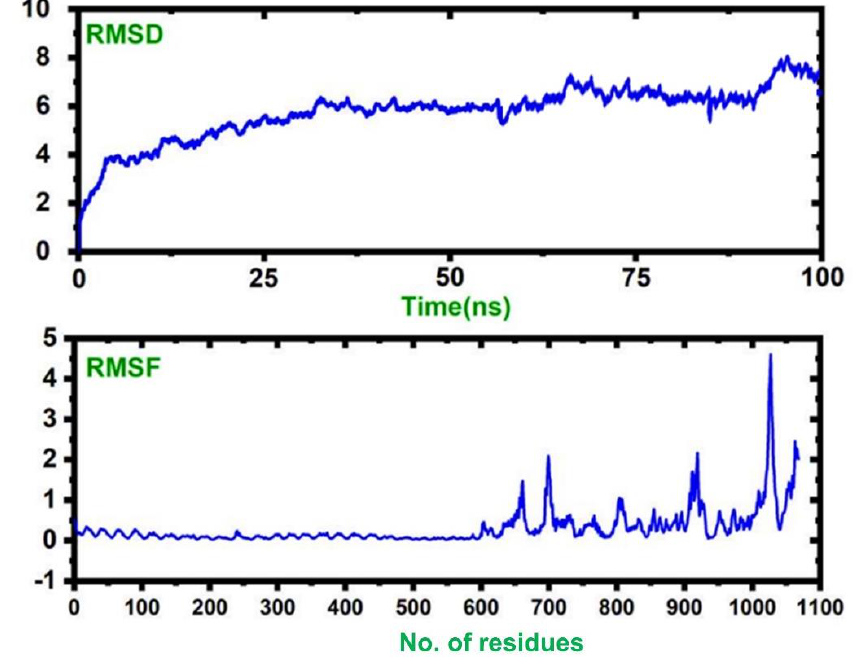
Figure 8. The dynamic stability, given as the RMSD, and the residual flexibility, given as the RMSF .